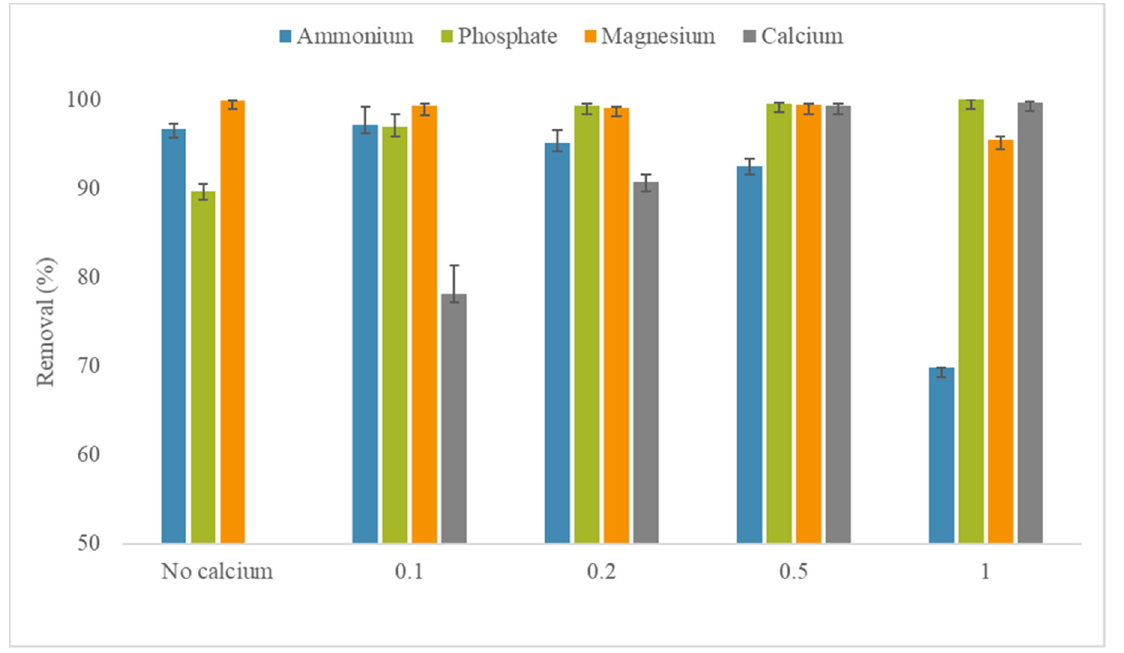
Figure 3. Ammonium, phosphate, magnesium, and calcium removal rates for the calcium salt source effects experiments (Mg 2+ :NH 4+ :PO 43 − = 1.25:1:1.25, pH = 9.5). The error bars represent ± one standard deviation for three replicate experiments.